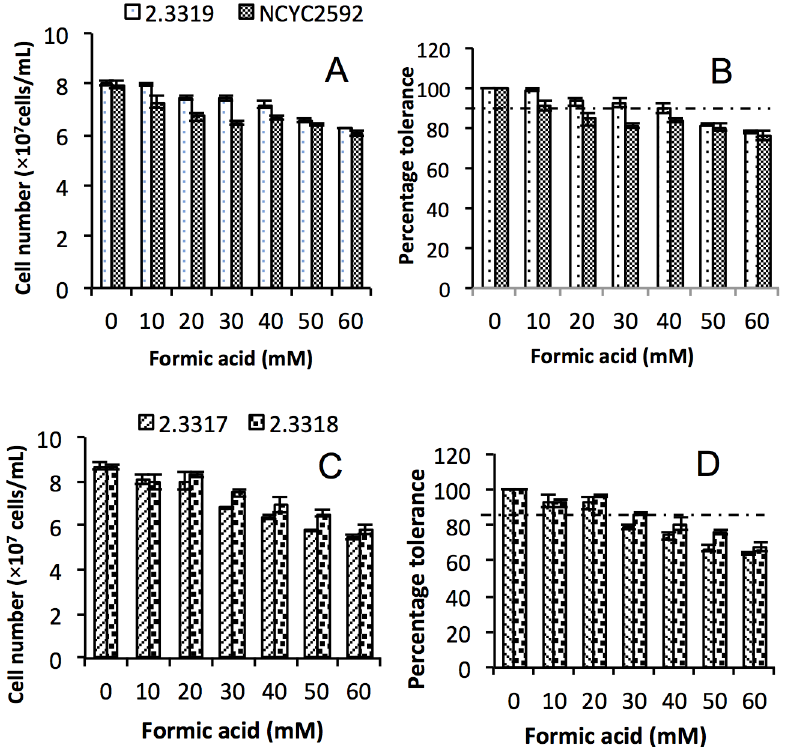
Fig 3. Growth profile (A and C) and percentage tolerance (B and D) of Saccharomyces arboricolus 2.3317, 2.3318 and 2.3319 and Saccharomyces cerevisiae NCYC2592 in the presence of formic acid (0 – 60 mM) using YPD medium. Values are the mean of three experiments and vertical error bars represent standard deviation.